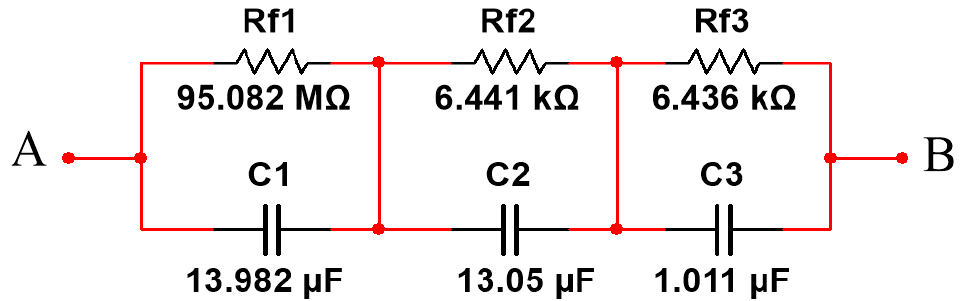
where Equation (12) can be constructed using chain fractance made up of three pairs of resistor capacitor, as shown in Figure 3: